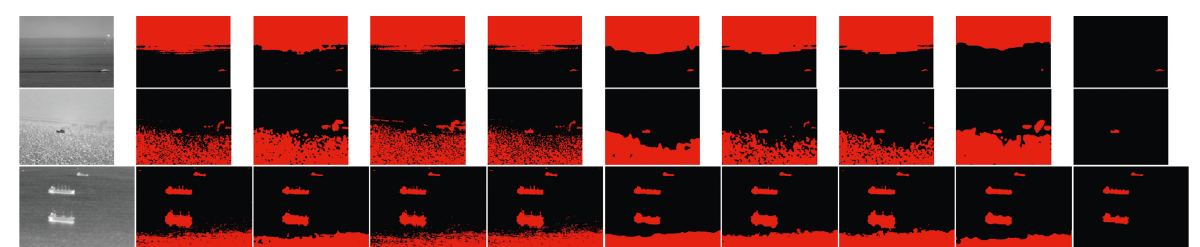
Figure 6: Comparison of different methods for infrared sea surface target image segmentation. The first column: input image; the second column: segmentation results of GAC model; the third column: segmentation results of LSR model; the fourth column: segmentation results